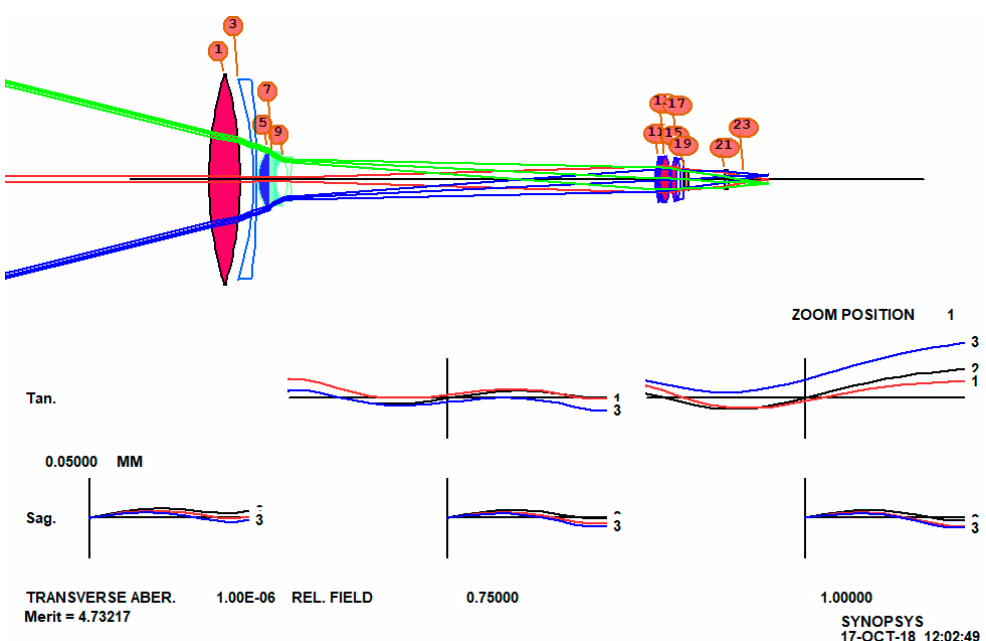
Figure 12. Zoom lens with element added by automatic element insertion (AEI).